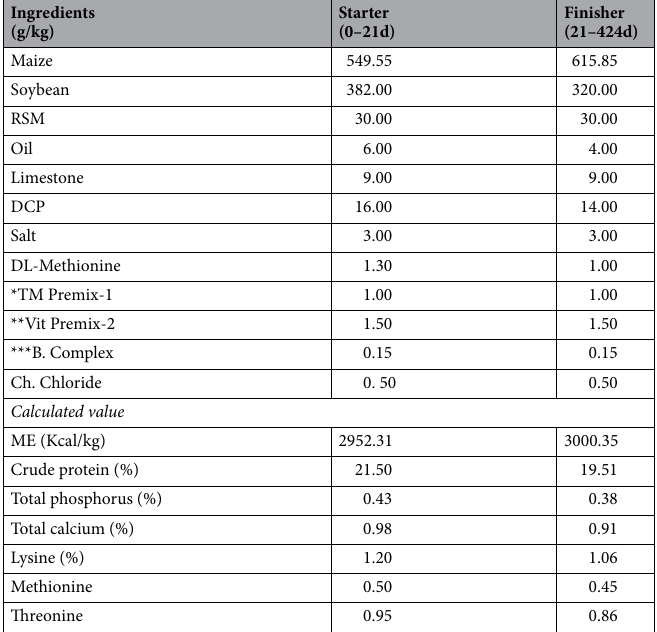
Experimental diets. Bacitracin methylene di-salicylate (BMD), with a certified 44% bacitracin activity,